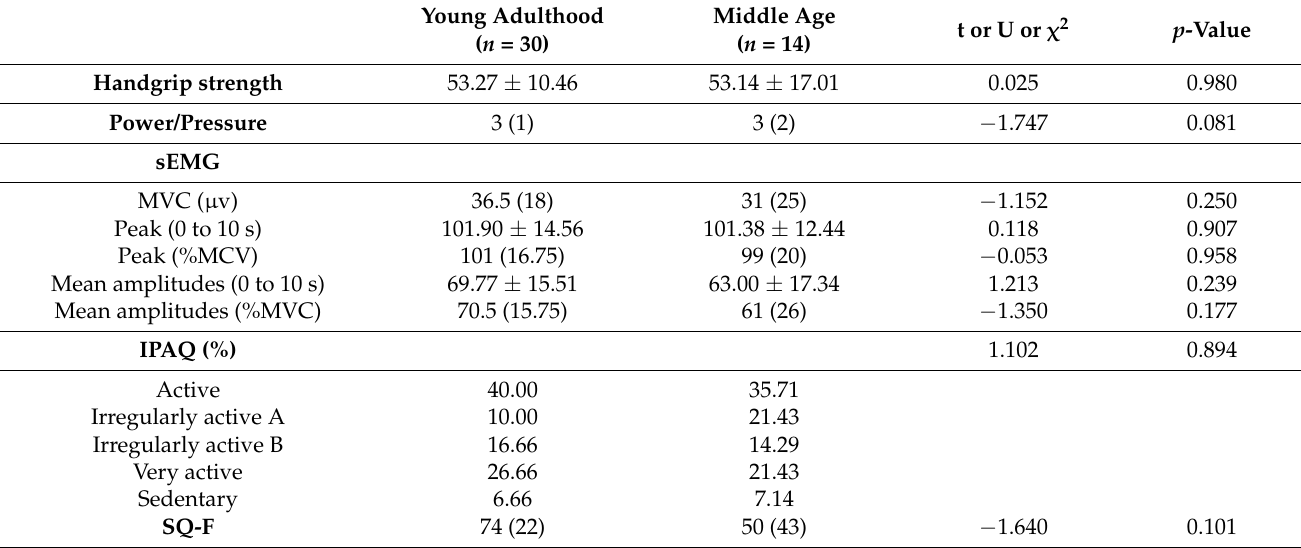
Table 3. Handgrip strength, level of strength and bioelectrical activity of the pelvic floor